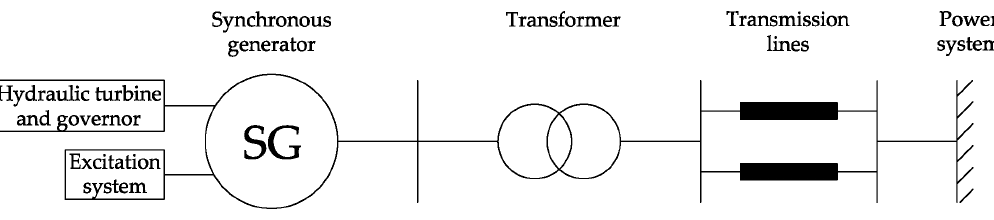
Figure 3. Synchronous generator connected to the power system.